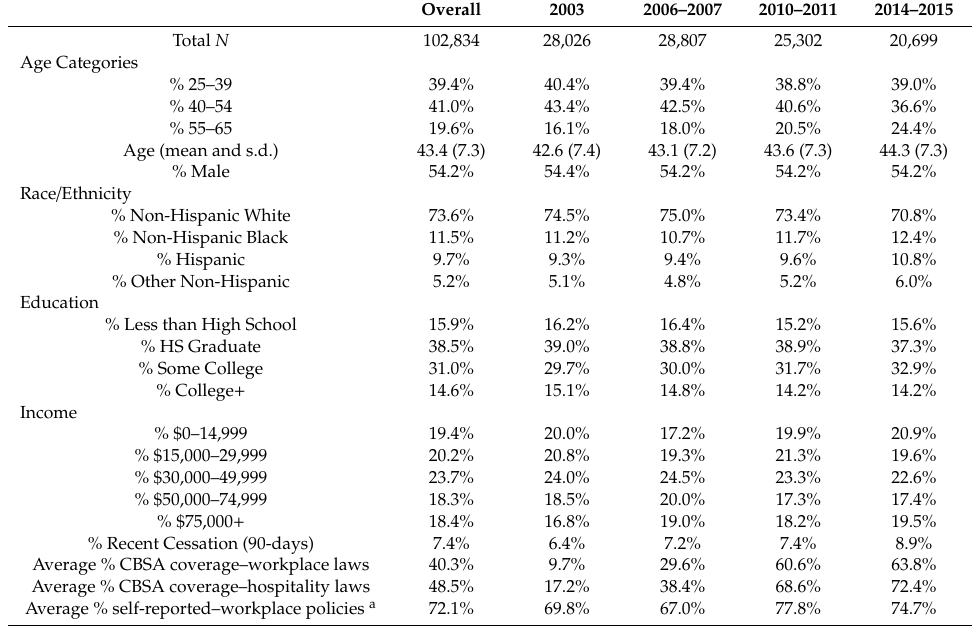
Table 1. Weighted characteristics of the U.S. Tobacco Use Supplement to the Current Population Survey (TUS-CPS) analytic sample, 2003–2015.